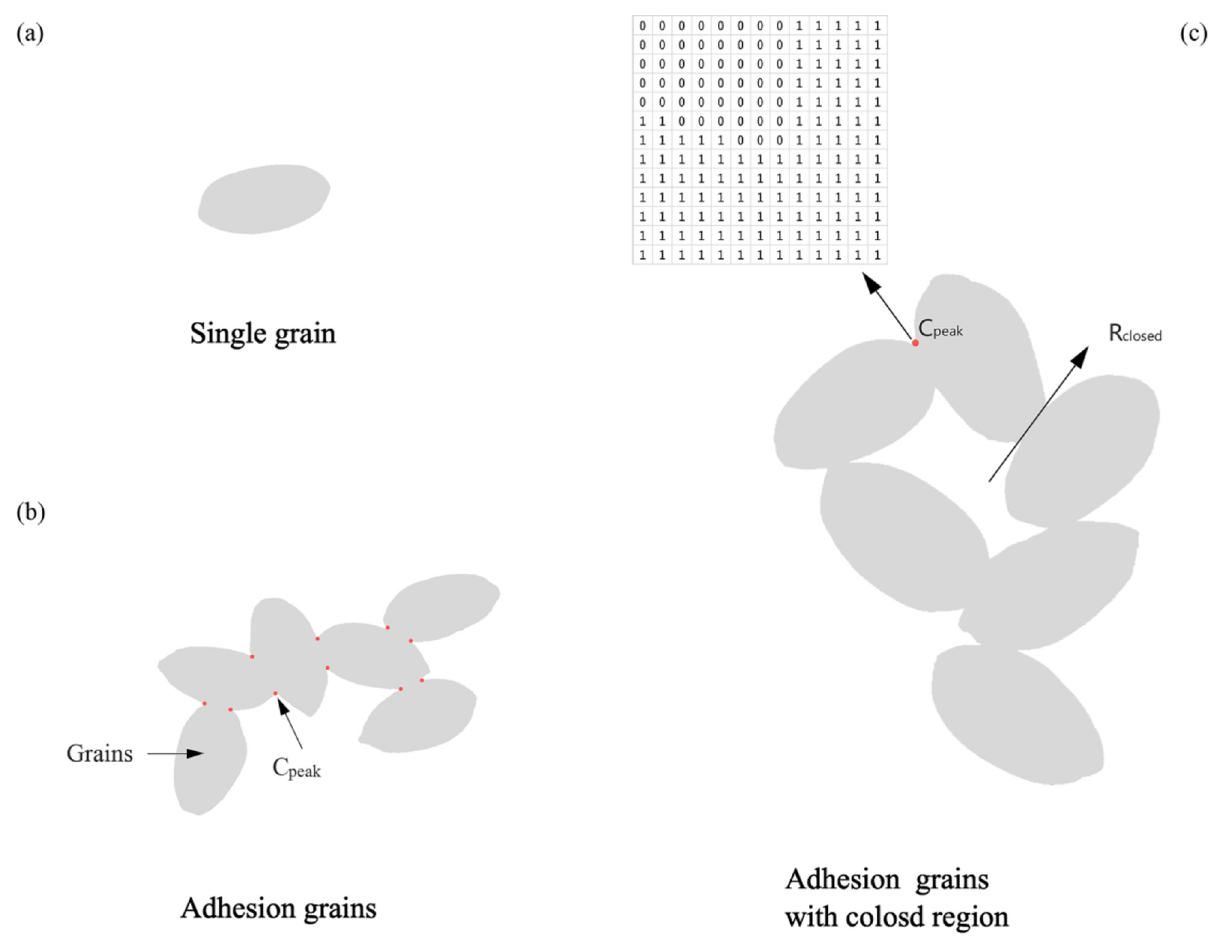
Fig 6. Grain topology and corner